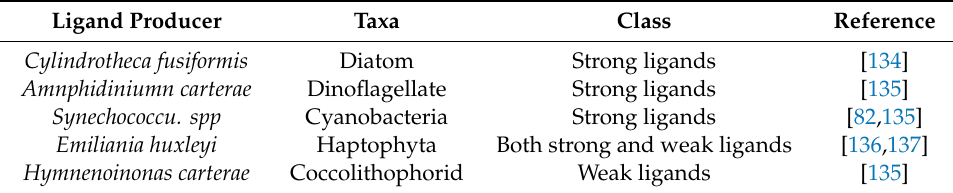
Table 2. Copper-complexing ligands produced by